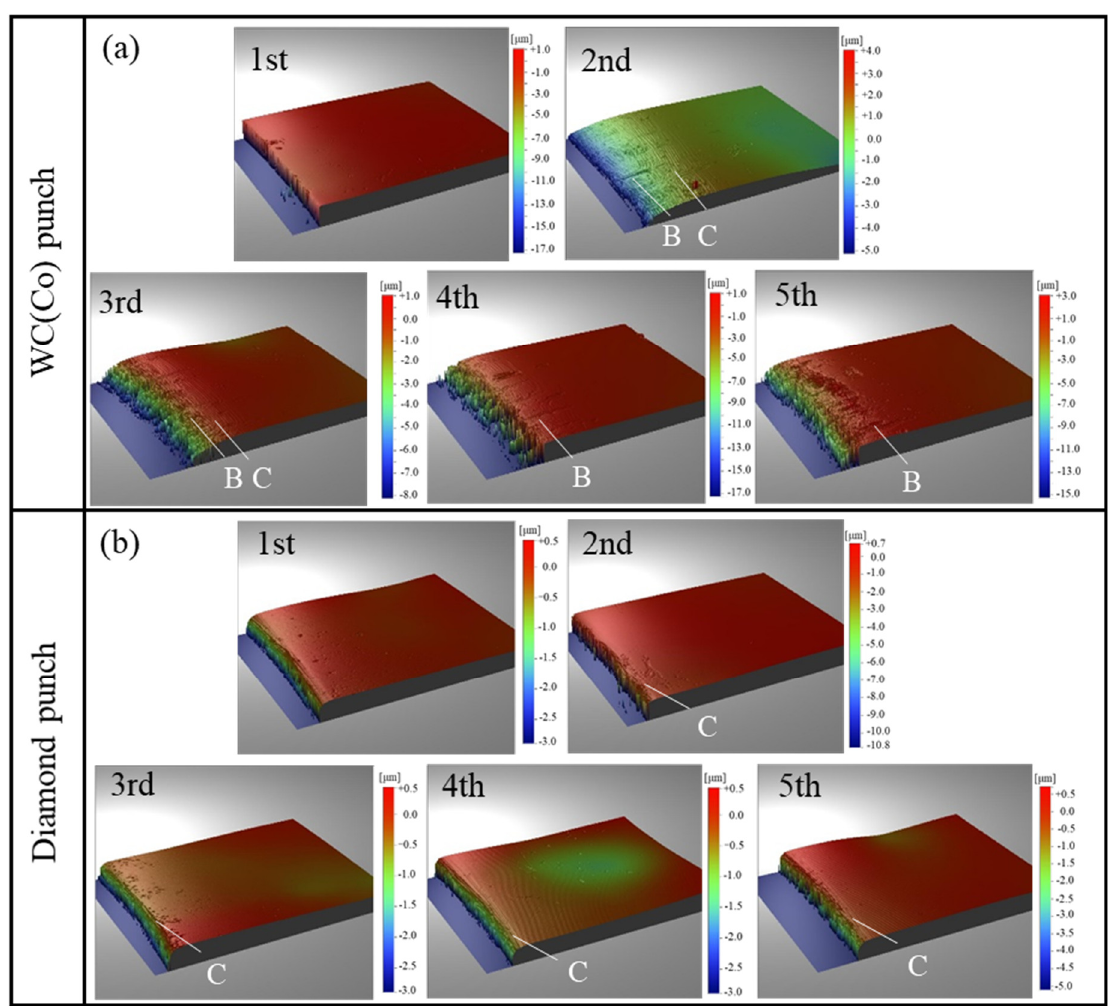
Figure 13. The surface profile of the pierced sheets in the radial direction from the hole. ( a ) Piercing by the WC (Co) punch, and ( b ) piercing by the diamond punch.